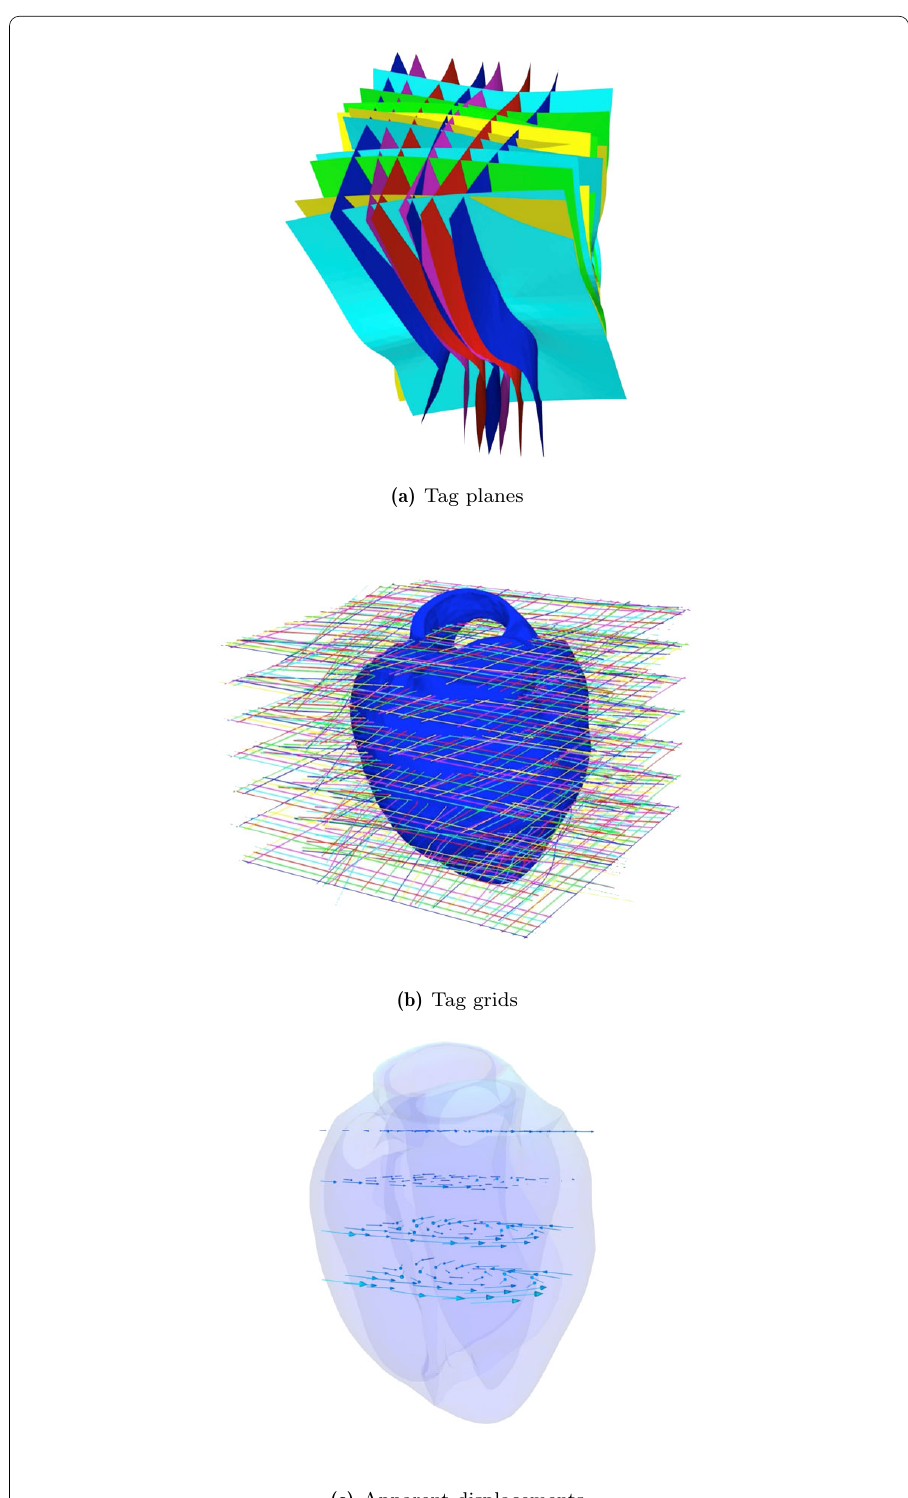
Fig. 10 Example of computations of synthetic data extracted from a direct simulation of an infarcted